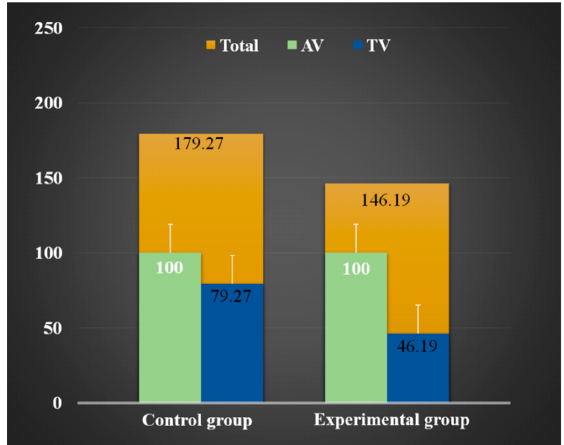
Figure 4. Preservative effect of anti ‐ mold properties of plywood.